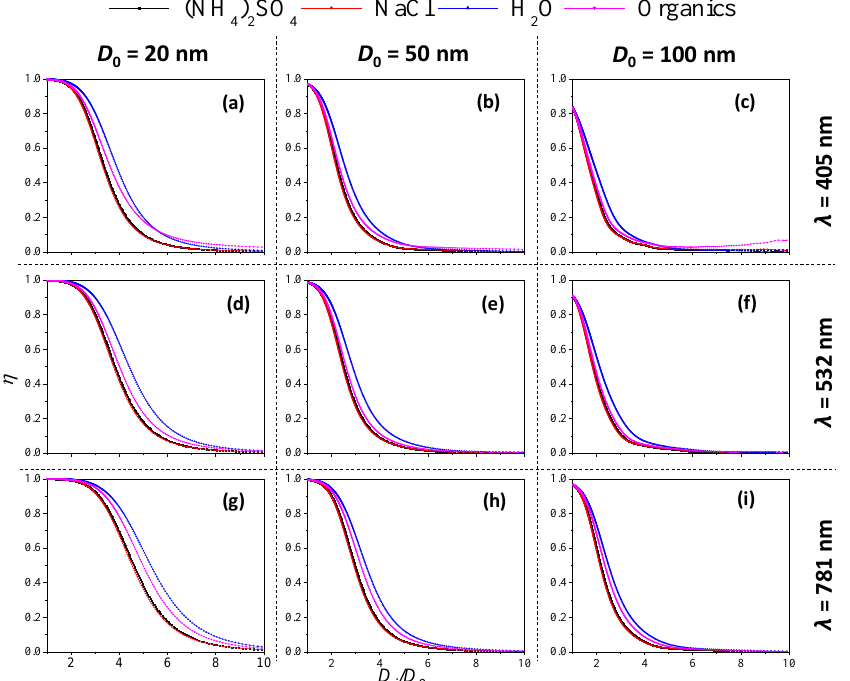
Figure 7. Variation in absorption proportion η with coating thickness ( D i / D 0 ) under various soot-particle coated materials ( λ = 405, 532 and 781 nm; soot particle diameter D 0 = 20, 50 and 100 nm). ( a – c ): ( λ = 405 nm; soot particle core diameter D 0 = 20, 50 and 100 nm); ( d – f ): ( λ = 532 nm; soot particle core diameter D 0 = 20, 50 and 100 nm); ( g – i ): ( λ = 781 nm; soot particle core diameter D 0 = 20, 50 and 100 nm);